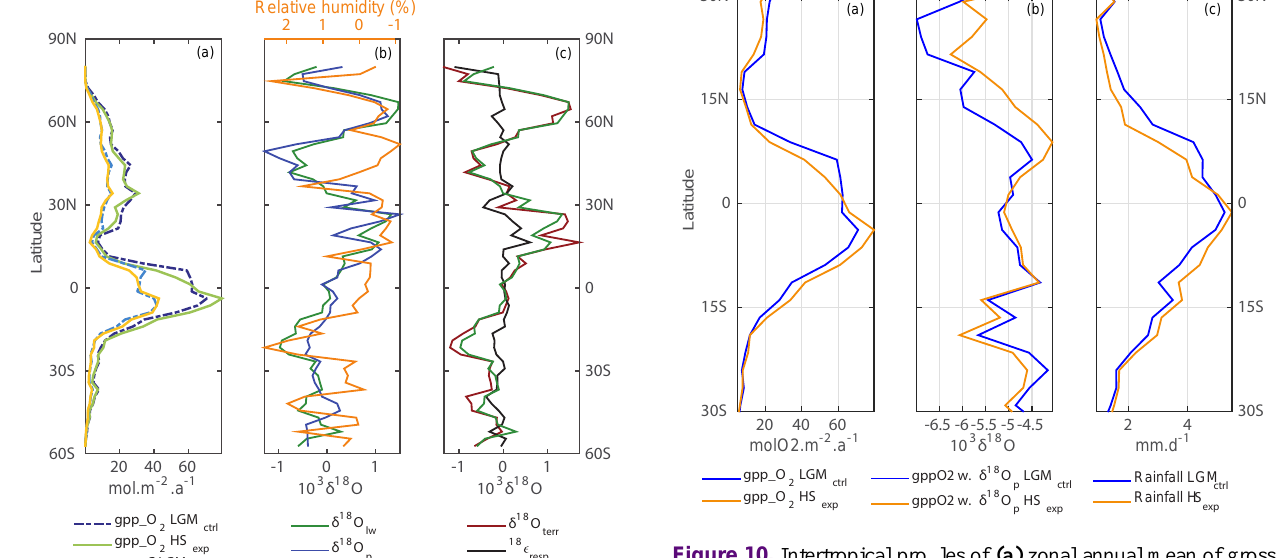
Figure 10. Intertropical profiles of (a) zonal annual mean of gross primary productivity expressed in terms of oxygen (GPP_O 2 ) an- nual molar fluxes for LGM_ctrl and HS_exp. (b) Zonal annual mean of oxygen-production-weighted δ 18 O p for LGM_ctrl and Figure 9. (a) Zonal annual mean of gross primary productivity ex- pressed in terms of carbon (GPP_C) and oxygen (GPP_O 2 ) annual HS_exp. (c) Zonal annual mean of rainfall amount for LGM_ctrl molar fluxes for LGM_ctrl and HS_exp, respectively. (b) Zonal and annual-mean anomalies of δ 18 O lw , δ 18 O p and relative humidity (note its inverted x axis). (c) Zonal annual-mean anomalies for 18 O − 18 (cid:15) resp , δ 18 O terr . Note that all variables of panels lw and δ (b) and (c) are oxygen-production- (GPP_O 2 ) weighted.